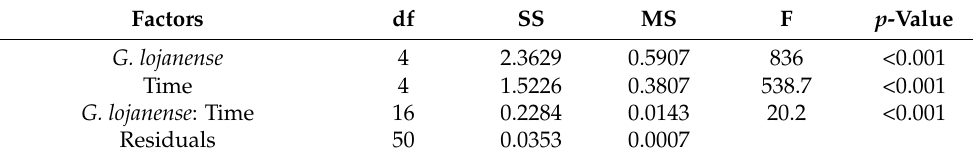
Table 6. Two-factor analysis of variance